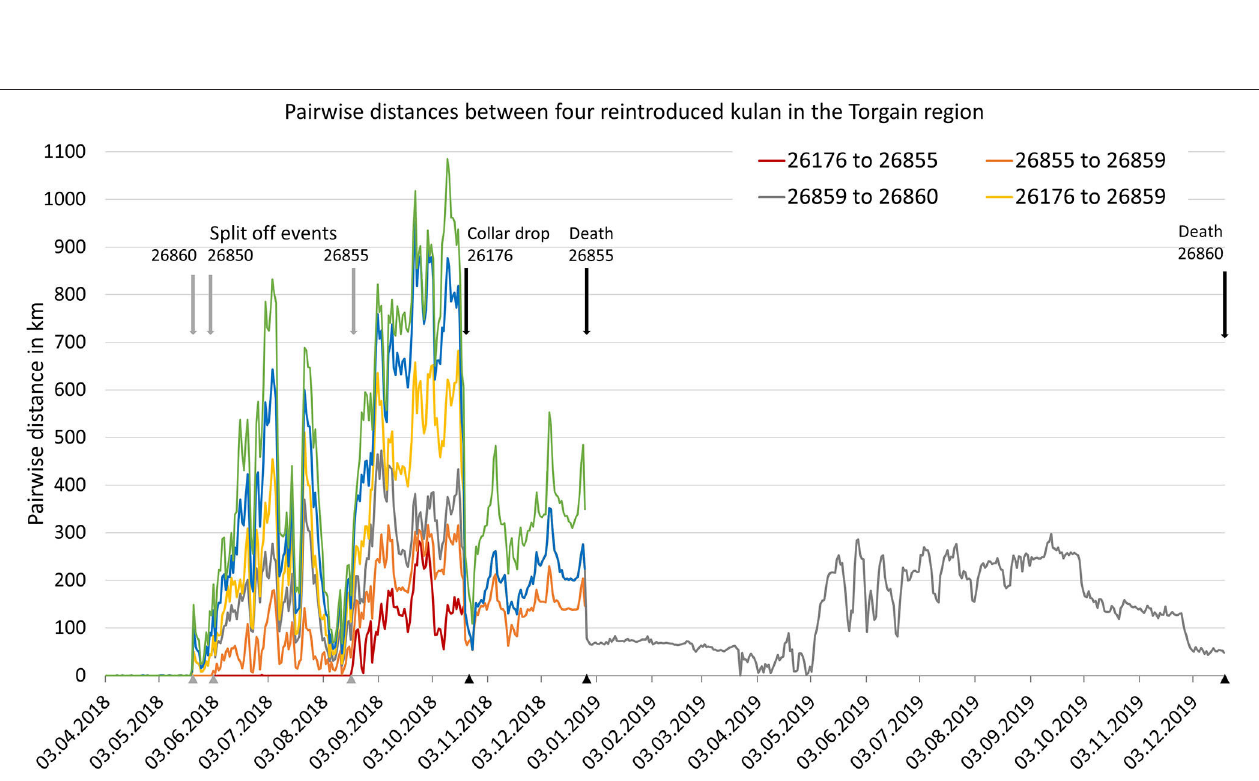
Frontiers in Conservation Science |